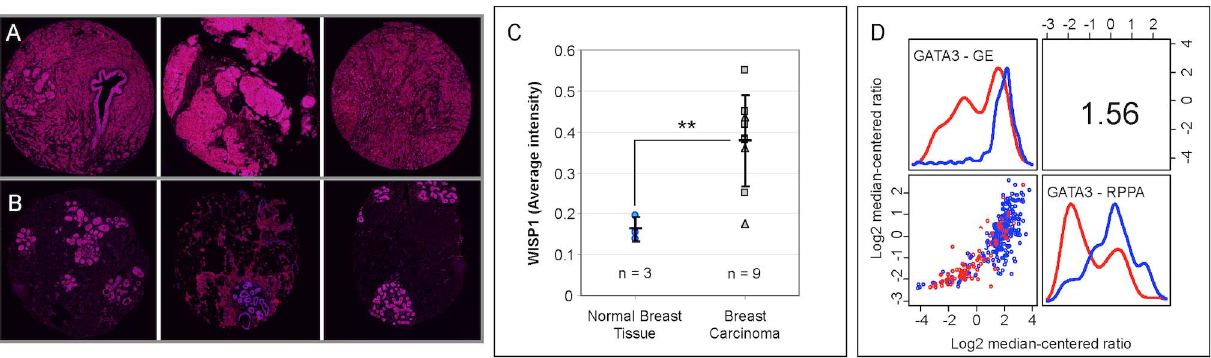
Figure 4. WISP1 and GATA3 gene expression correlate with protein expression. Representative deconvoluted color images derived from a breast cancer tissue microarray probed using a WISP1 antibody and imaged using 3,3 9 diaminobenzidine and stained using hematoxylin for three invasive breast cancer (A - top) and three normal breast (B - bottom) tissue samples (original tissue microarray images were obtained from www. proteinatlas.org [64]). Deconvoluted intensity of WISP1 staining is shown in red while cellular structures stained using hematoxylin are shown in blue. (C) The average intensity of WISP1 staining, as determined by color deconvolution of the RGB tissue microarray images, was increased in breast carcinoma (** indicates a p-value , 0.001, as estimated using an unpaired two-tailed Student’s t-test). Summary statistics are shown as mean + / 2 SD. The number of replicates included in the analysis is indicated by n. (D) GATA3 gene expression as quantified by Affymetrix microarray correlated with GATA3 protein expression as quantified by reverse phase protein array. In panel D, a bivariate scatter plot for the 340 joint measurements is shown below the diagonal, marginalized histograms stratified by the two breast cancer groups are shown on the diagonal, and a correlation coefficient is shown above the